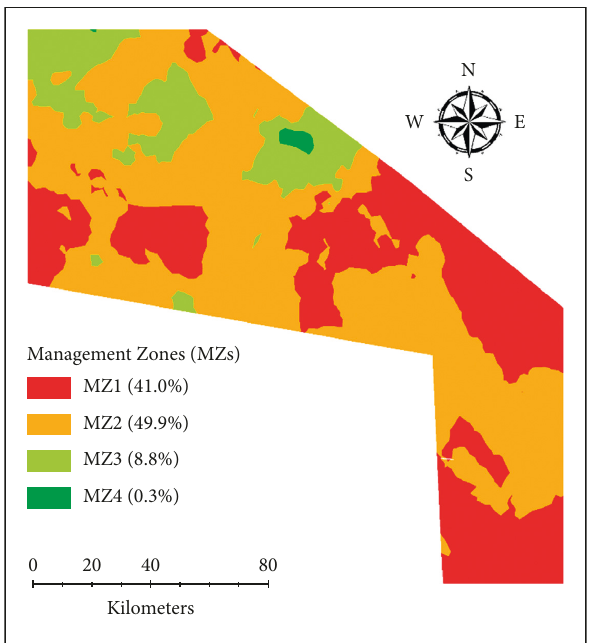
Figure 5: Management zones map for the study